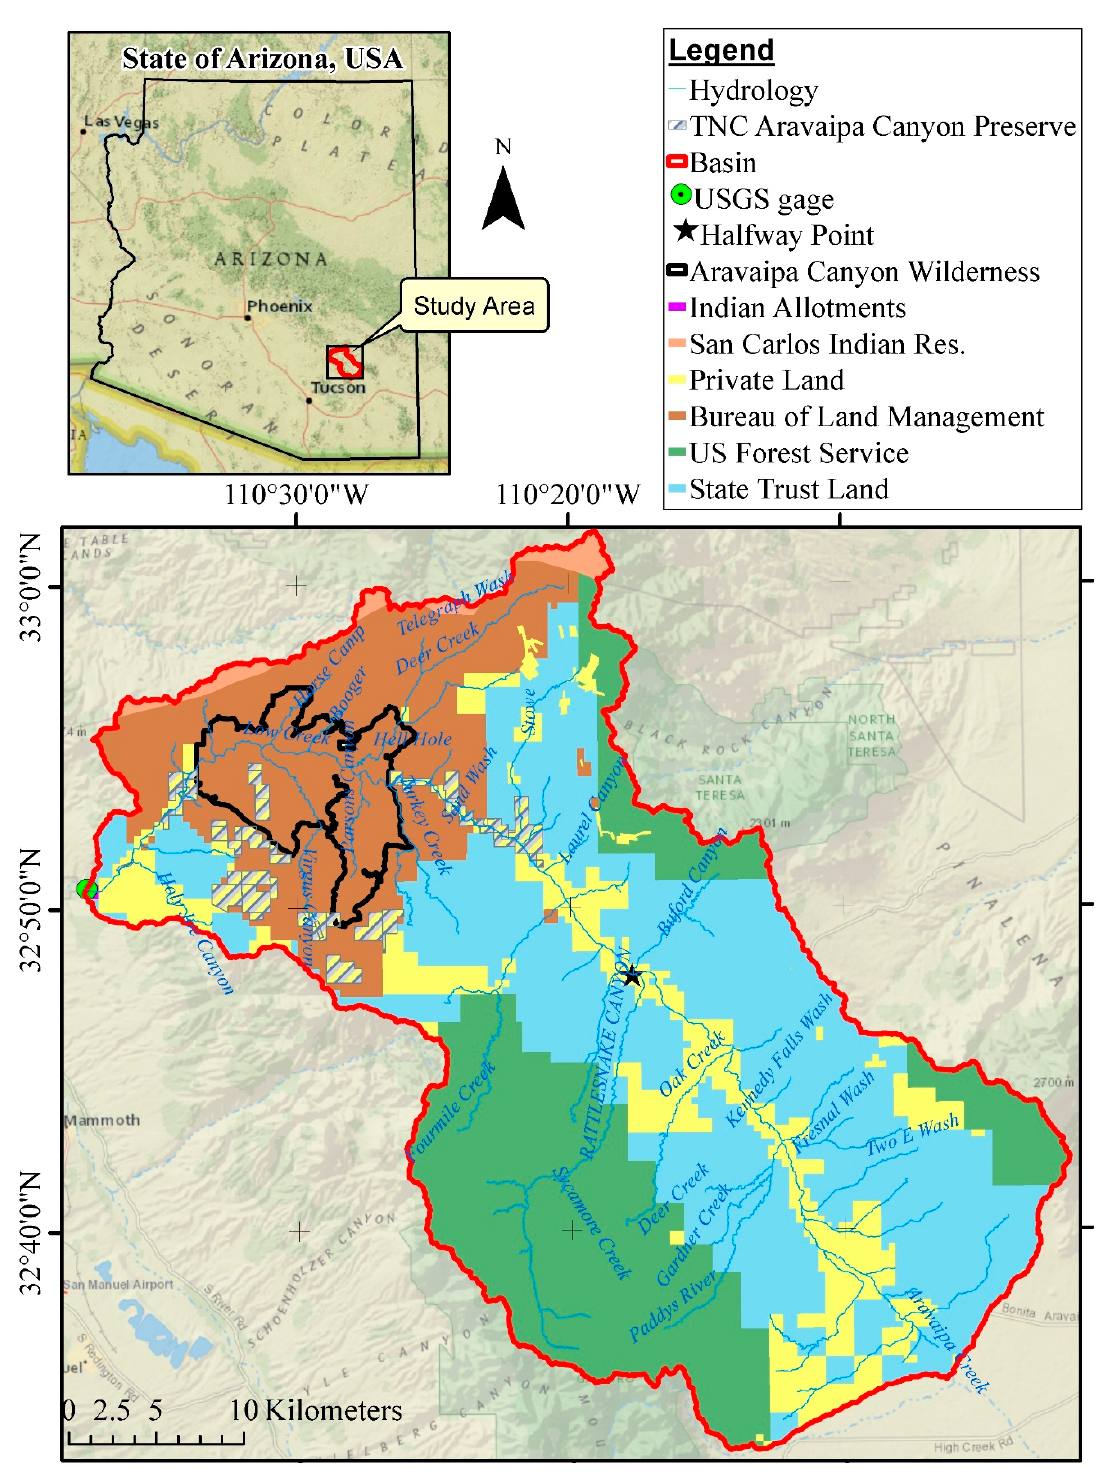
Figure 1. Location of the Aravaipa Watershed Basin (red outline) within the State of Arizona, the landownership, major streams, USGS gaging station, and Wilderness